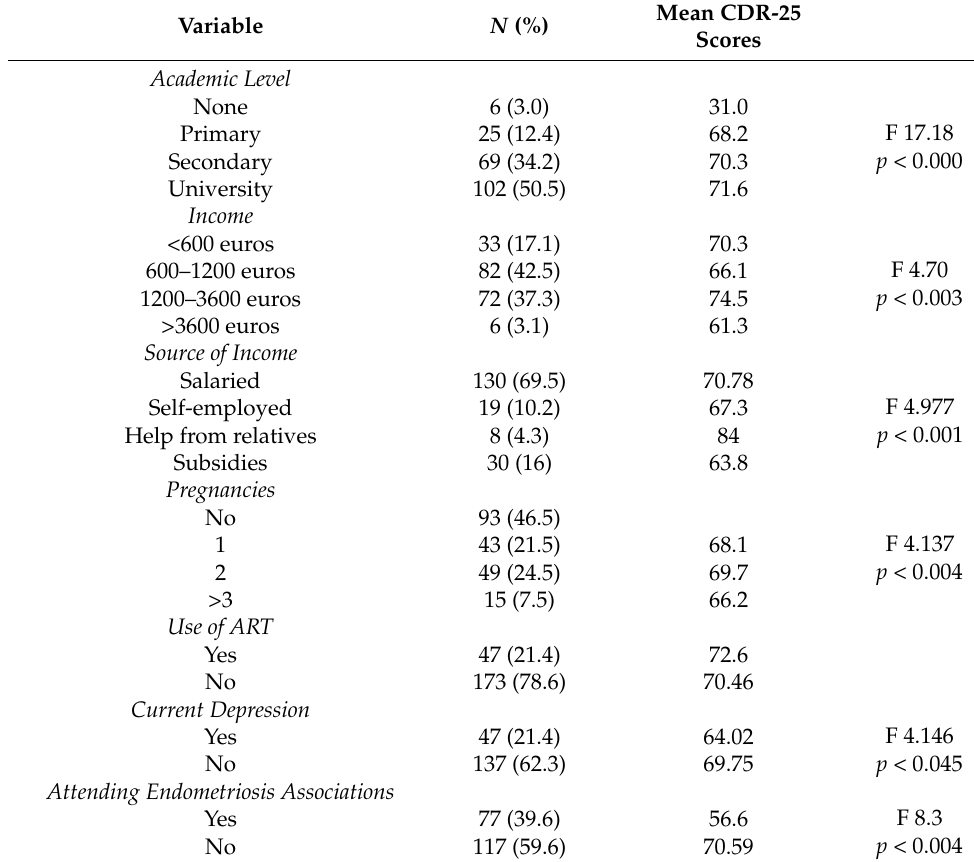
Table 3. Mean values for CDR-25